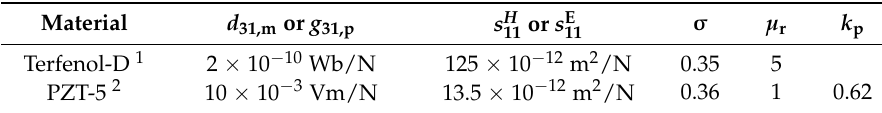
Table 1. The parameters of Terfenol-D and PZT-5.